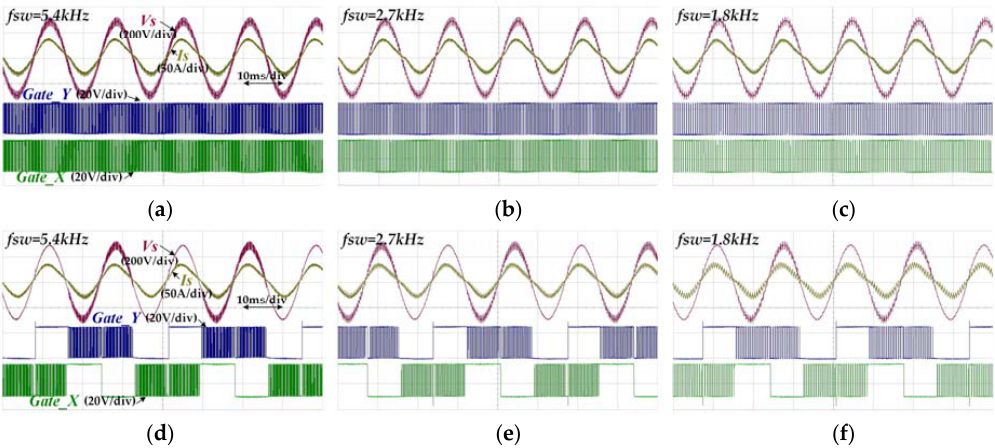
Figure 13. Comparisons of experimental main waveforms utilizing CB-SPWM ( a – c ) and proposed DPWM ( d – f ).